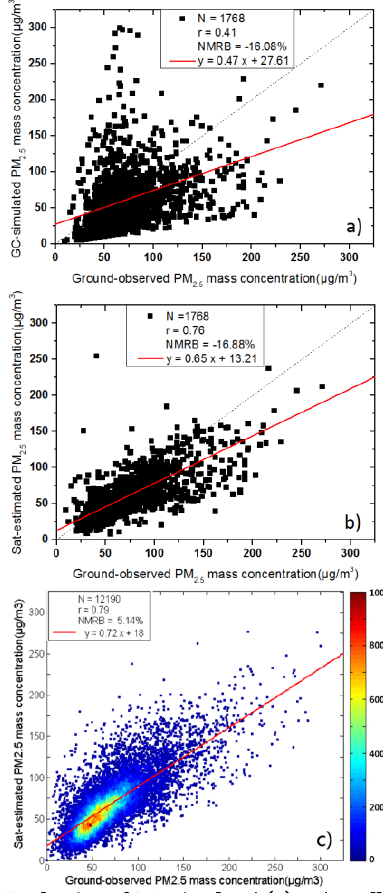
Figure 2. Evaluation of GC-simulated ( a ) and satellite-derived ( b , c ) monthly mean PM 2.5 using ground measurements from 2004 to 2014. ( a , b ) indicate the results obtained at the coarse resolution, and ( c ) represents the comparison between ground measurements and satellite-derived results at a resolution of 0.1° × 0.1°. The color bar represents the number of data with those particular ordered pair